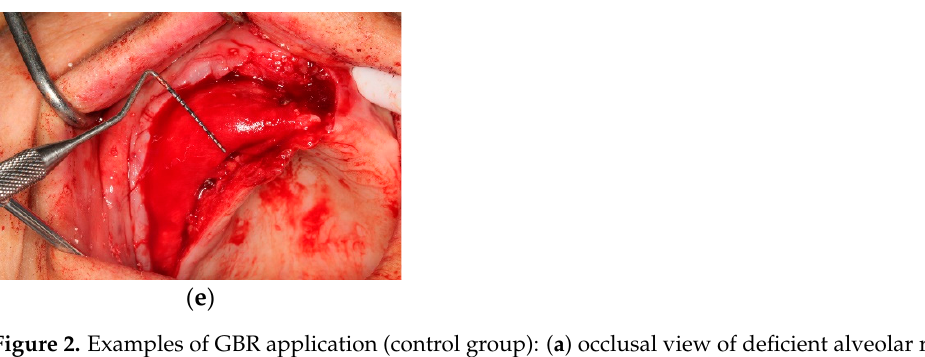
Figure 2. Examples of GBR application (control group): ( a ) occlusal view of deficient alveolar ridge; ( b ) decortication of recipient site; ( c ) ratio of approximately 1:1 ABB and autogenous bone chips; ( d ) placement of the graft; ( e ) resorbable collagen membrane fixed with tacks.